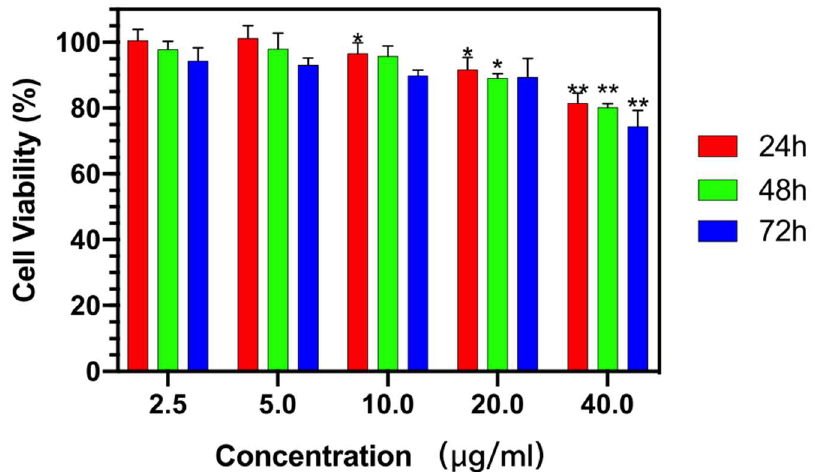
Figure 8. In vitro cell viability analysis of RSA treated for 24, 48 or 72 h at concentrations of 2.5, 5, 10,